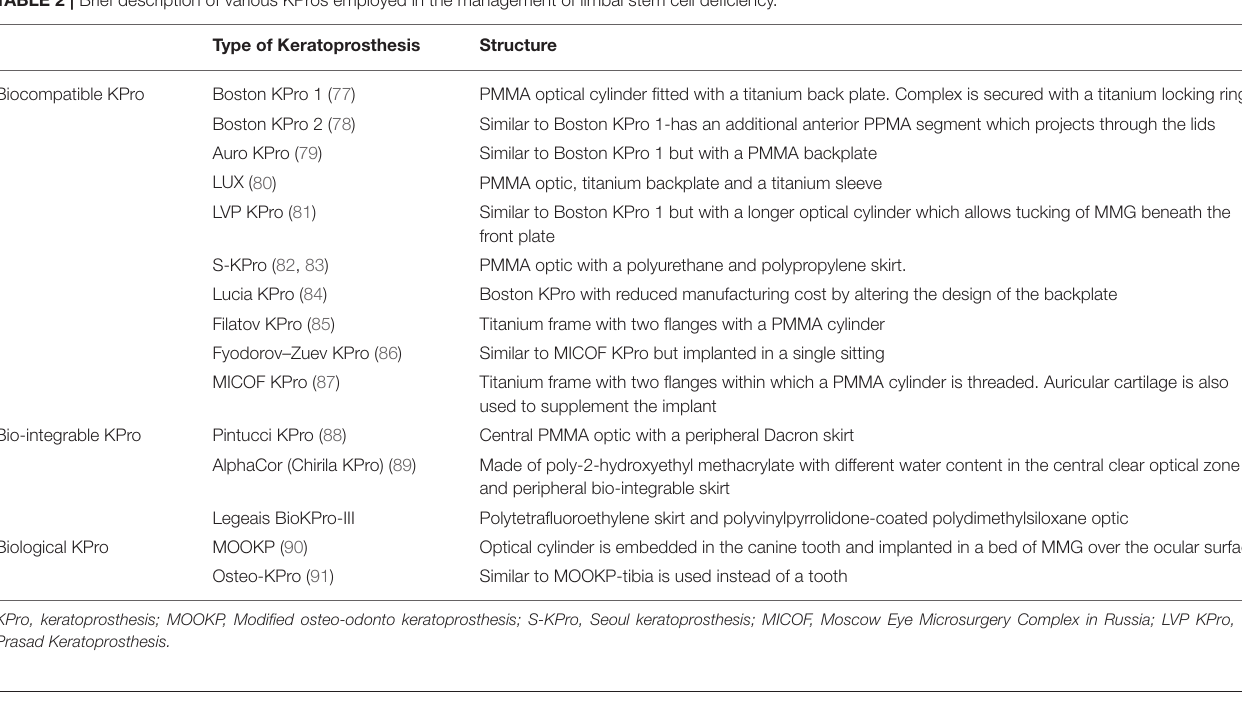
TABLE 2 | Brief description of various KPros employed in the management of limbal stem cell deficiency.